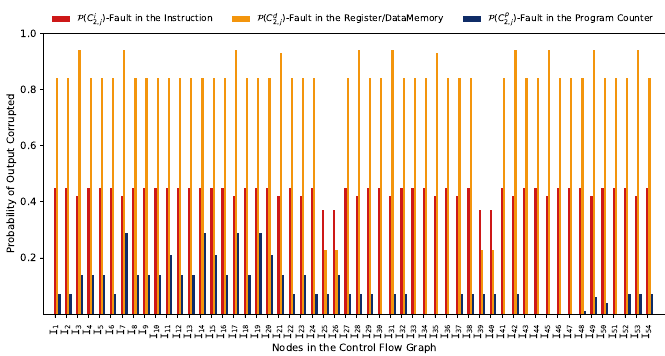
Figure 7: The probability of a fault corrupting the output of instructions given in Figure 3 on an TI MSP-430 processor. Faults can be induced either in the instruction, memory, or in the program